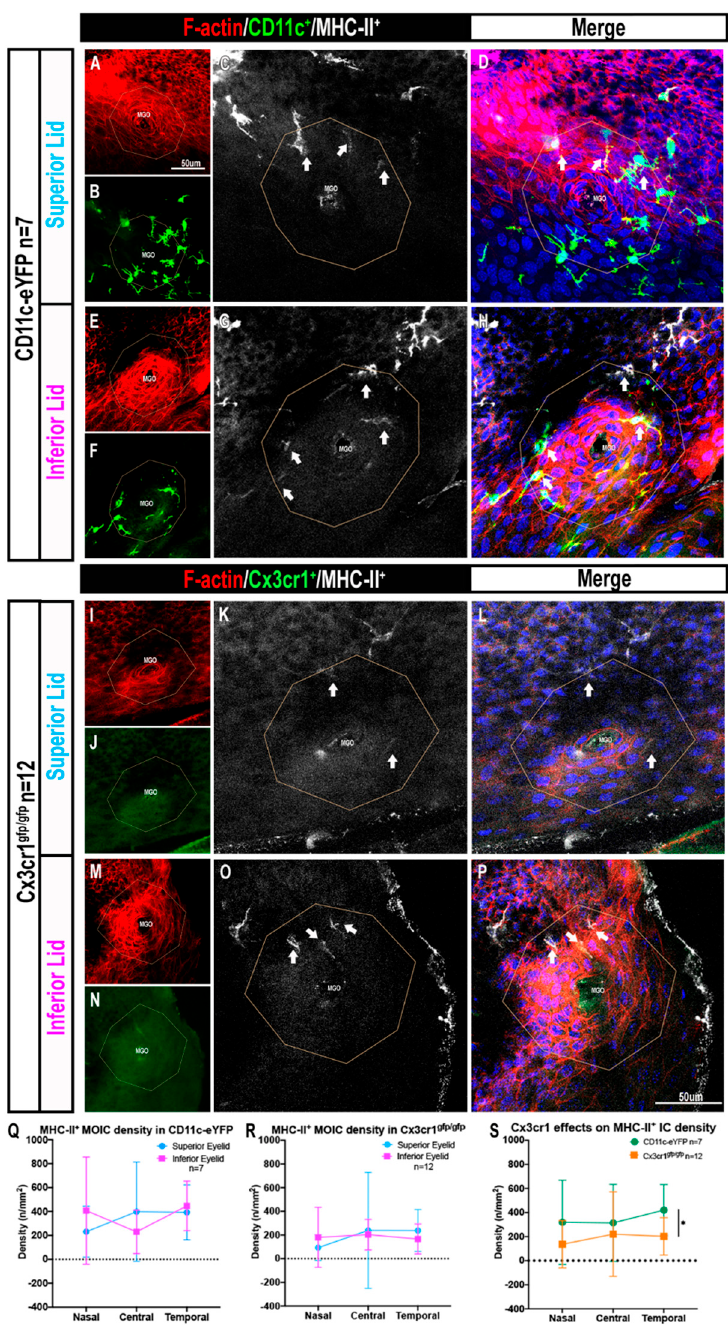
Figure 4. Confocal microscopy images of MHC-II + MOICs. F-actin (red) highlighting the MGO in CD11c-eYFP mice; superior lid ( A – D ) and inferior lid ( E – H ), and Cx3cr1 gfp/gfp mice; superior lid ( I – L ) and inferior lid ( M – P ). White arrows are MOICs that are MHC-II + . Graph represents MHC-II + MOIC distribution in CD11c-eYFP ( Q ) and Cx3cr1 gfp/gfp ( R ) mice and the effects of Cx3cr1 deficiency on MHC-II + MOIC density along the eyelid margin ( S ). All data are presented as mean ± SD, (* p ≤ 0.05). Scale bar in ( A ) applies to panels ( B , E , F , I , J , M , N ), and in ( P ) applies to panels ( C , D , G , H , K , L , O , P ). In Cx3cr1 gfp/gfp (deficient) mice, MHC-II + MOICs were observed in the superior (Figure 4I–L) and inferior eyelids (Figure 4M–P). Quantitative analysis revealed no differ- 2.4. MOICs Express CD11c and Cx3cr1 in CD11c-eYFP Mice ences in MHC-II + MOIC density across the eyelid regions (nasal: 137 ± 196 cells/mm 2 vs. central: 221 ± 351 cells/mm 2 vs. temporal: 202 ± 155 cells/mm 2 , p > 0.05) and